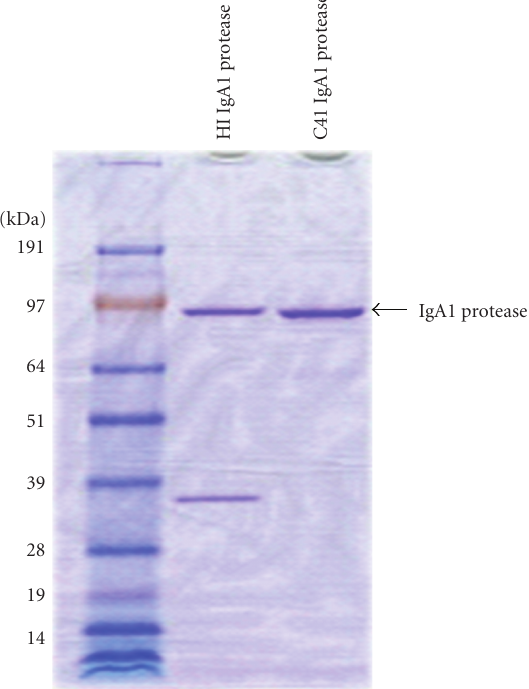
Figure 6: Characterization of purified IgA1 proteases from E. coli C41 (DE3) and H. influenzae. SDS-PAGE and Coomassie blue stain (reduced condition). HI IgA1 protease: Purified IgA1 protease from H. influenzae ; C41 IgA1 protease: purified IgA1 protease from E. coli C41